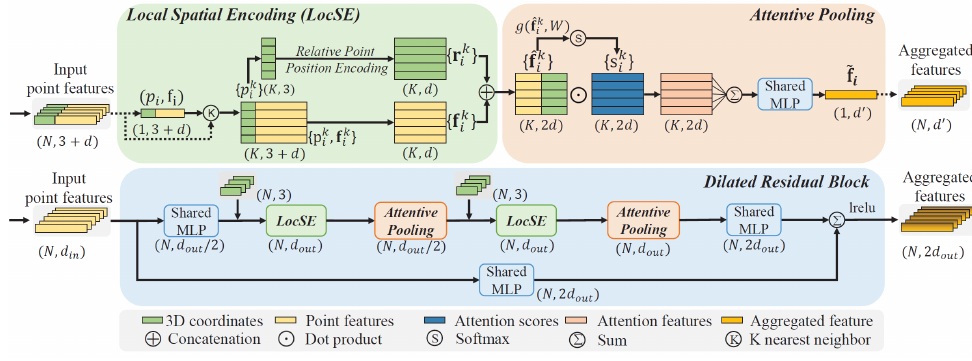
Figure 7. RandLA-Net [60] basic module.